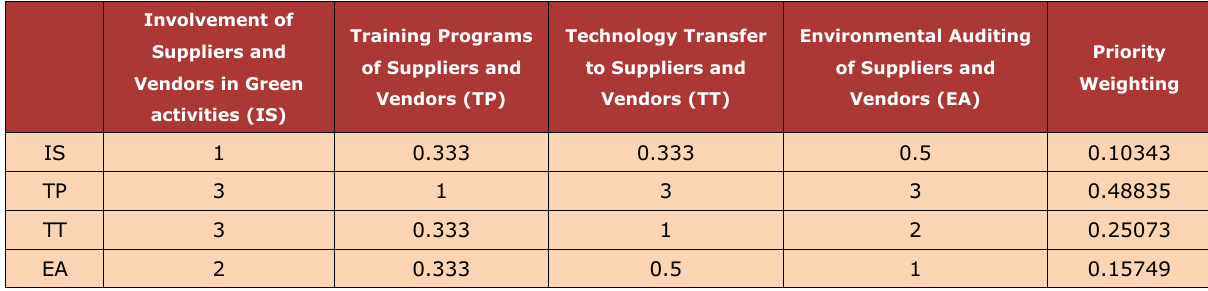
Table 4. Strategies of Downward stream supply chain members (Dimension 2)